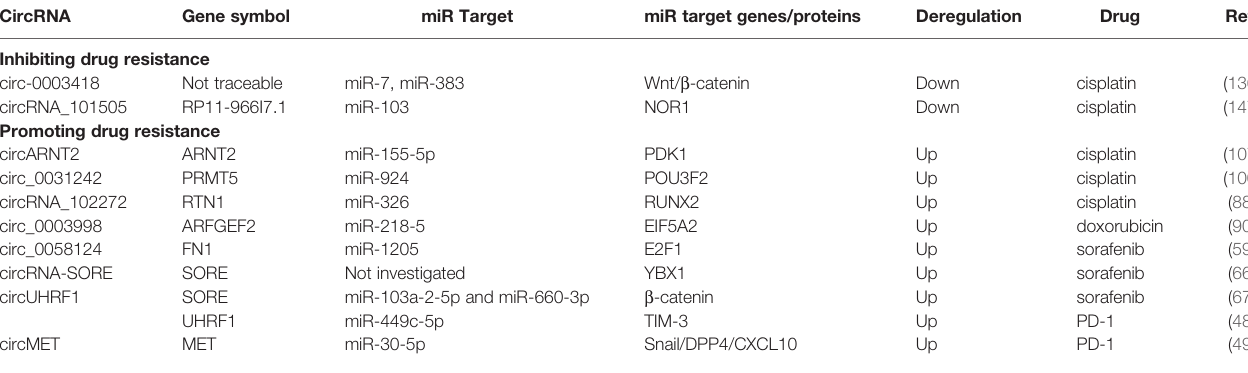
TABLE 3 | Deregulation and roles of circular RNAs in drug resistance of hepatocellular carcinoma.